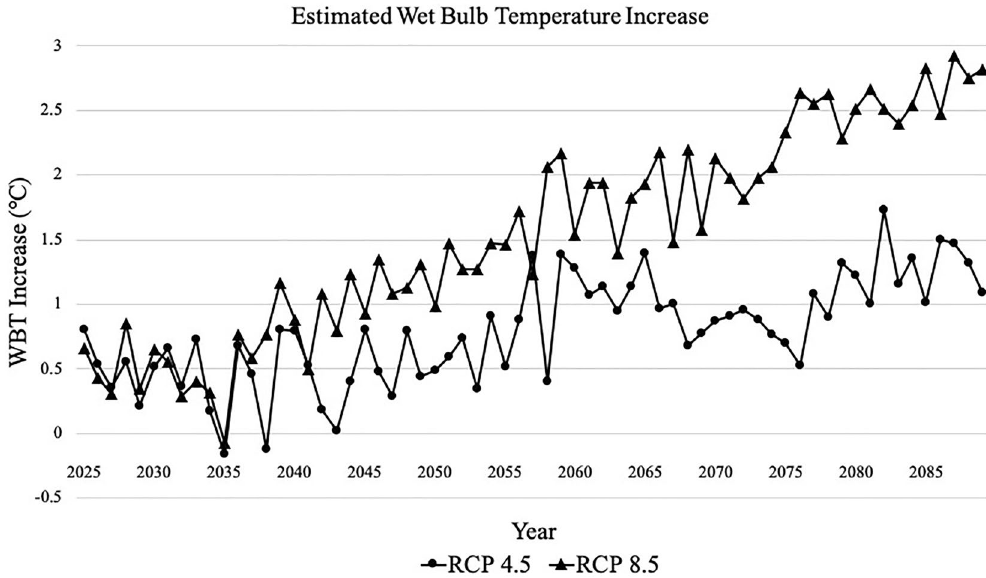
Figure 1. Increase in average annual WBT above average WBT between 1997 and 2014 for projected years in RCP 4.5 and RCP 8.5. Higher future WBT are associated with RCP 8.5 compared to RCP 4.5, due to greater projected future greenhouse gas concentration.